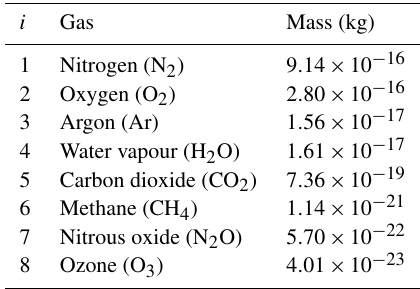
Table 2. Gas components comprising the system to be examined, and their